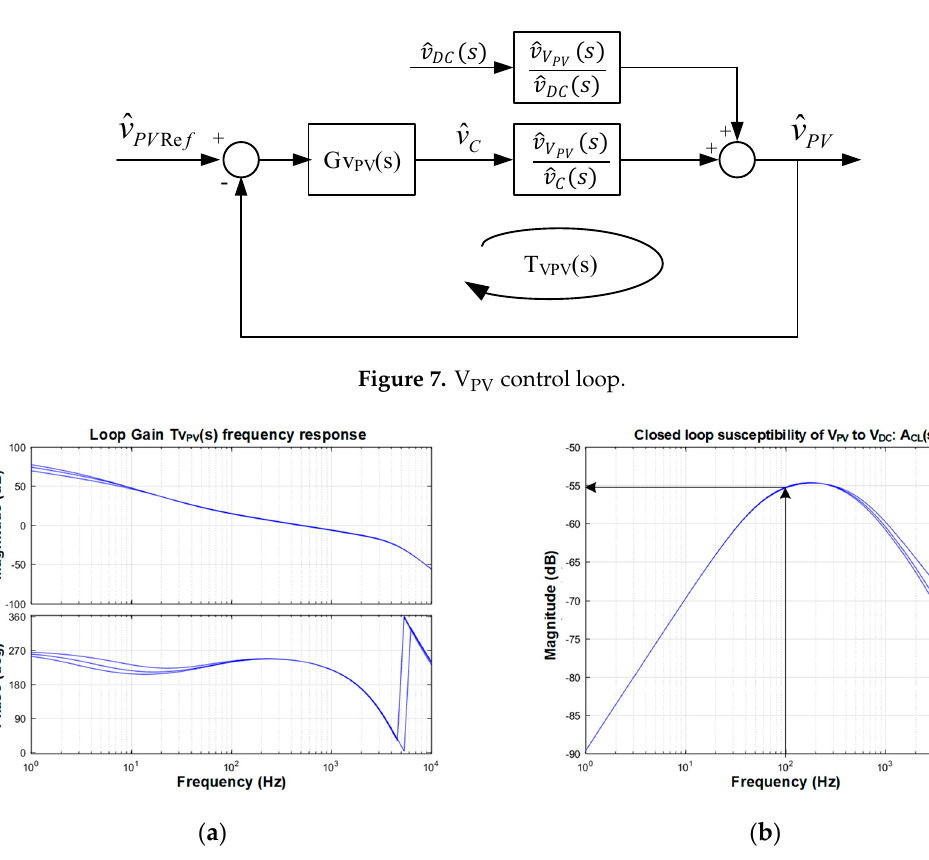
Figure 8. Frequency response of V PV control loop: ( a ) T VPV (s) loop gain of the V PV control loop and ( b )